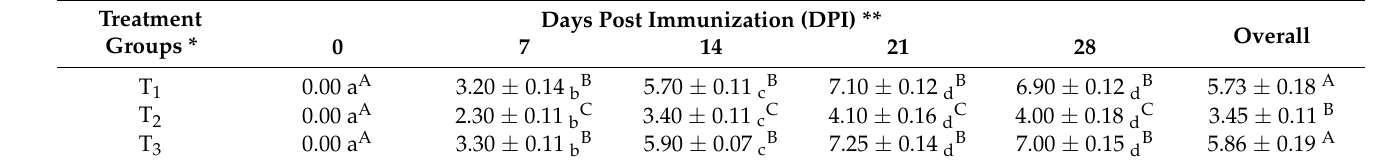
Table 3. Serum antibody titers (Mean ± SE) in chicks against the NDV isolates used for immunization: (T 1 ) chicken-adapted NDV of duck origin (PSD44C), (T 2 ) chicken-adapted NDV of parrot origin (PSP91C) and (T 3 ) Control (LaSota vaccine